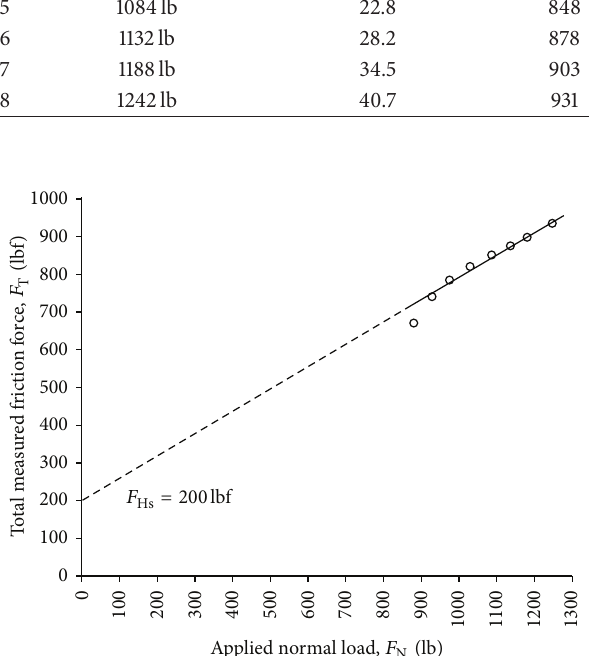
Figure 16: Dry Tyrone Boulevard test